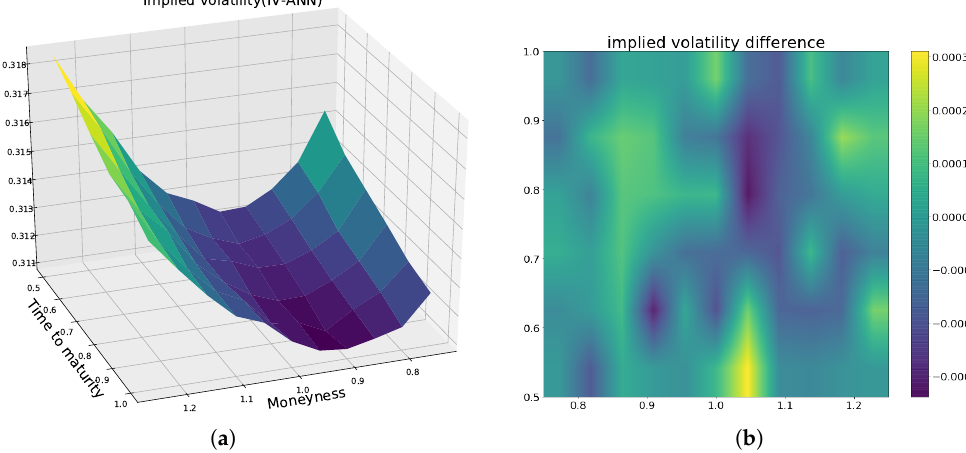
Figure 12. ( a ) Heston implied volatility surface generated by IV-ANN. ( b ) Heston implied volatility difference between Brent’s method and